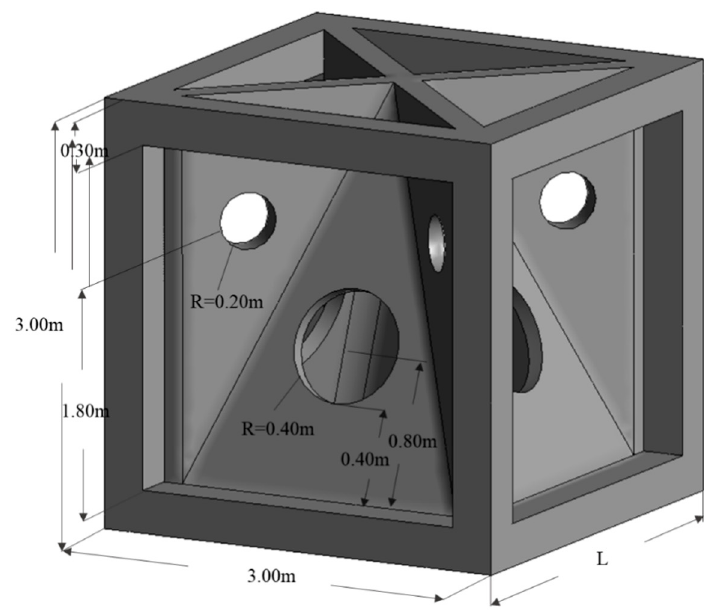
Figure 1. The upwelling reef.